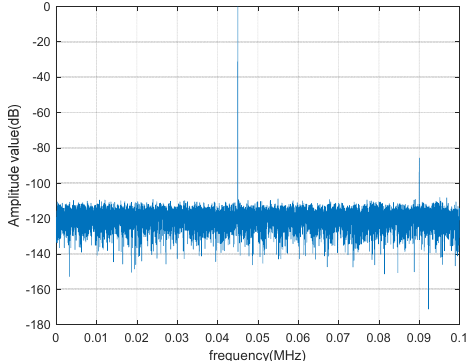
C = 3686). N = 16384, WIN DATA